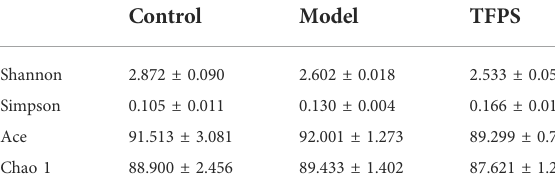
TABLE 1 Effects of TFPS on the a -diversity index of gut